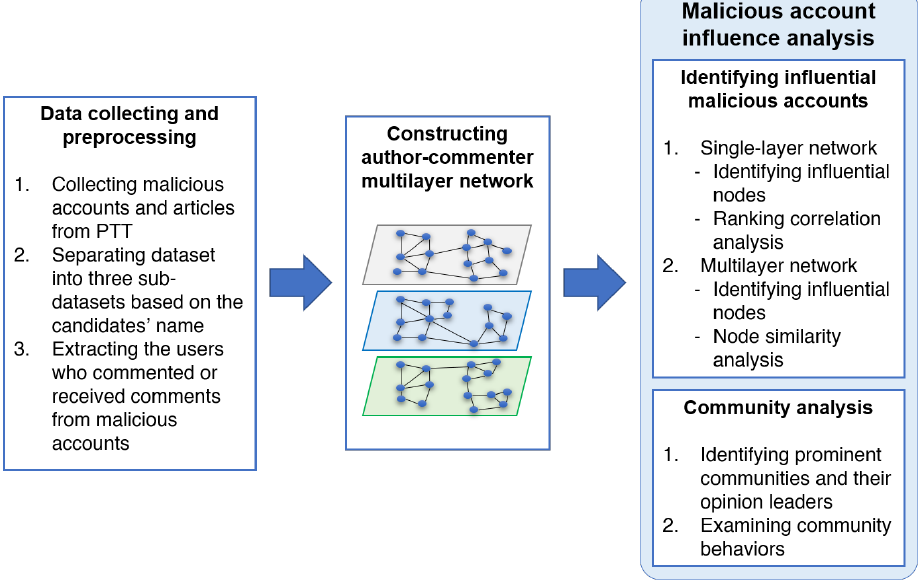
Figure 1. Overview of our